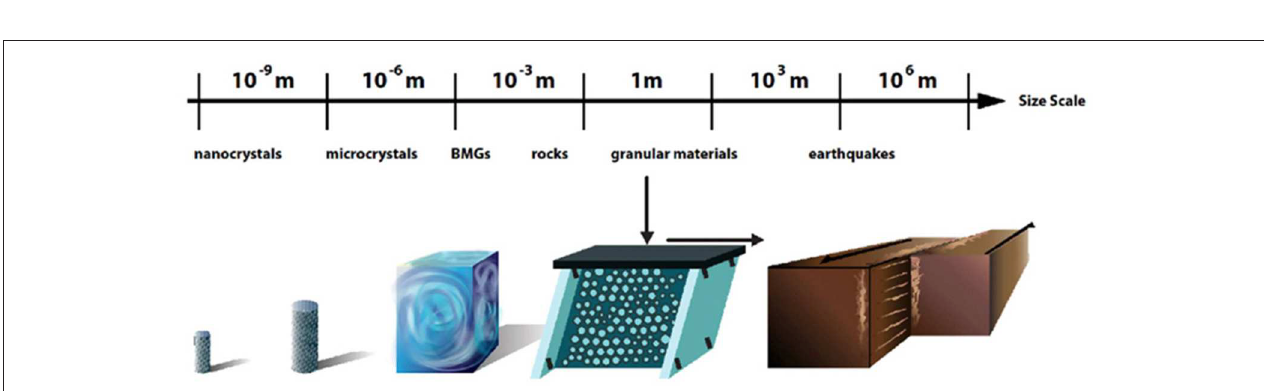
FIGURE 7 | Sketch of size scales of samples showing the same slip avalanche statistics and spanning 12–13 decades in length [Reprinted from Uhl et al. [5] licensed under